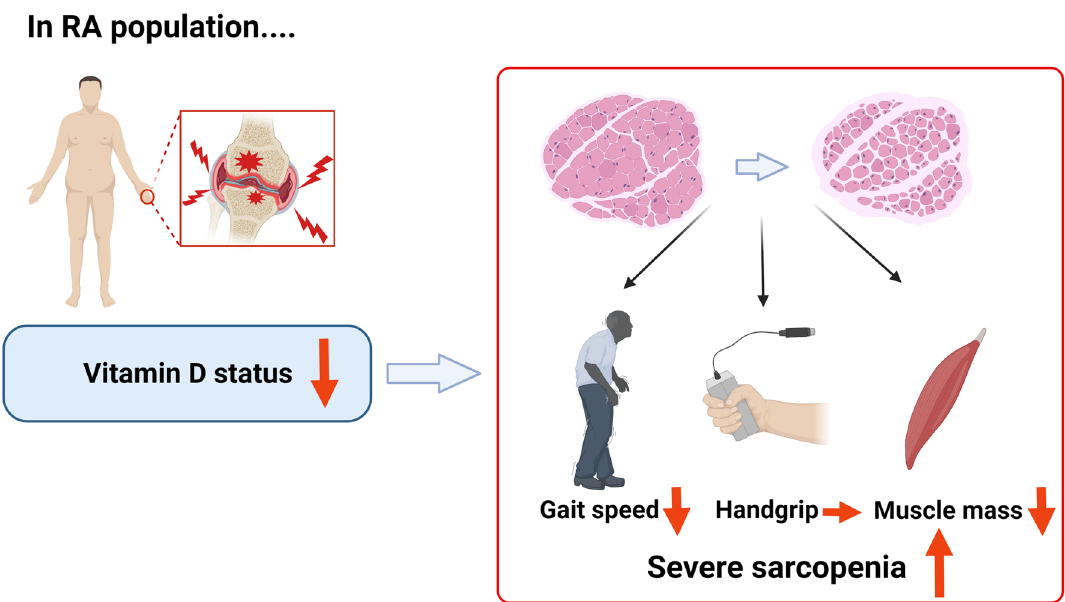
Figure 2. A proposed model of the relationship between vitamin D status, severe sarcopenia and its components in RA patients. In this study, vitamin D deficiency were strongly associated with increased prevalence of severe sarcopenia and impaired lower limb performance and skeletal muscle in RA patients. Modification strategy of vitamin D status including vitamin D supplementation may contribute to the improvement of sarcopenia in RA. This figure was created with BioRender.com (https:// biore nder. com/). RA rheumatoid